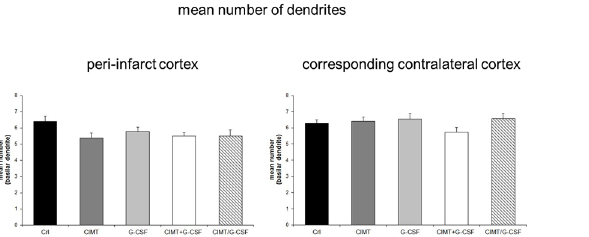
Fig 2. Quantitative analysis of Golgi Cox-impregnated layer V pyramidal neurons in the peri-infarct cortex and in the corresponding contralateral cortex. There were no differences in the number of basilar dendrites between the various experimental groups neither in the peri-infarct cortex nor in the corresponding contralateral cortex (Values are expressed as mean number of basilar dendrites ± SEM).